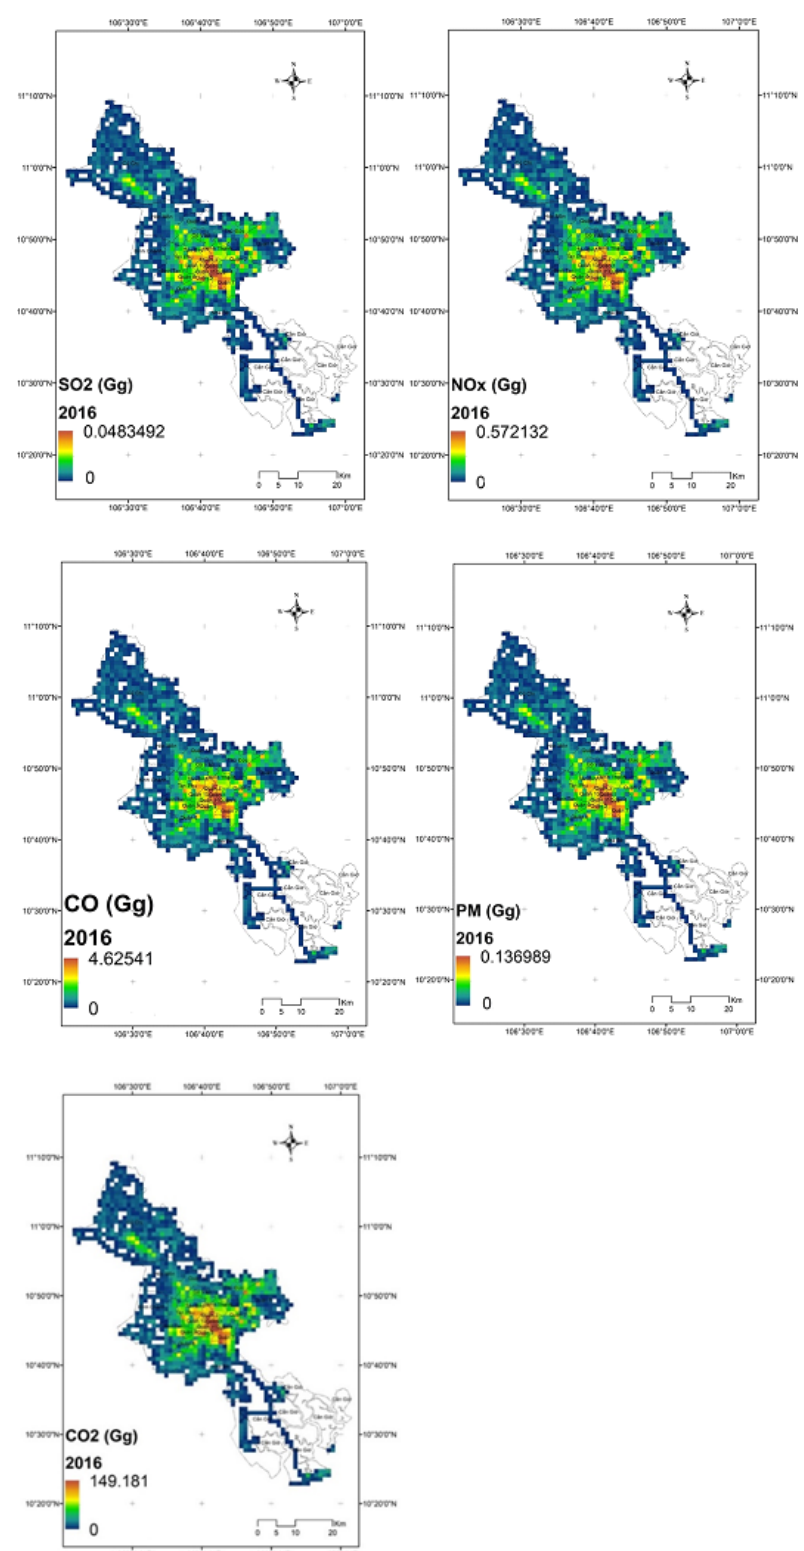
Figure 7. Emission maps of NO x , SO 2 , CO, PM and CO 2 in 2016 in HCMC as the sum of three key sectors: transportation, manufacturing industry and